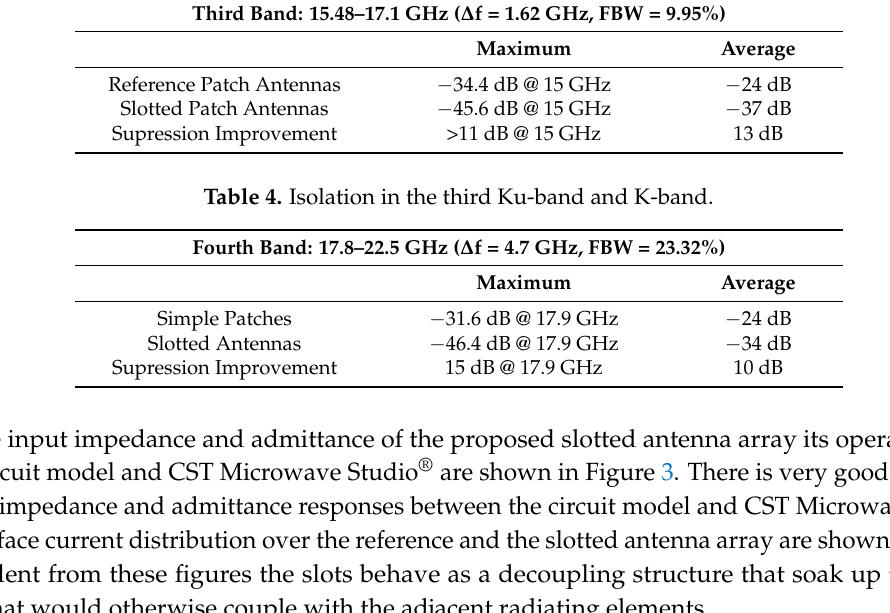
Table 3. Isolation in the second Ku-band.